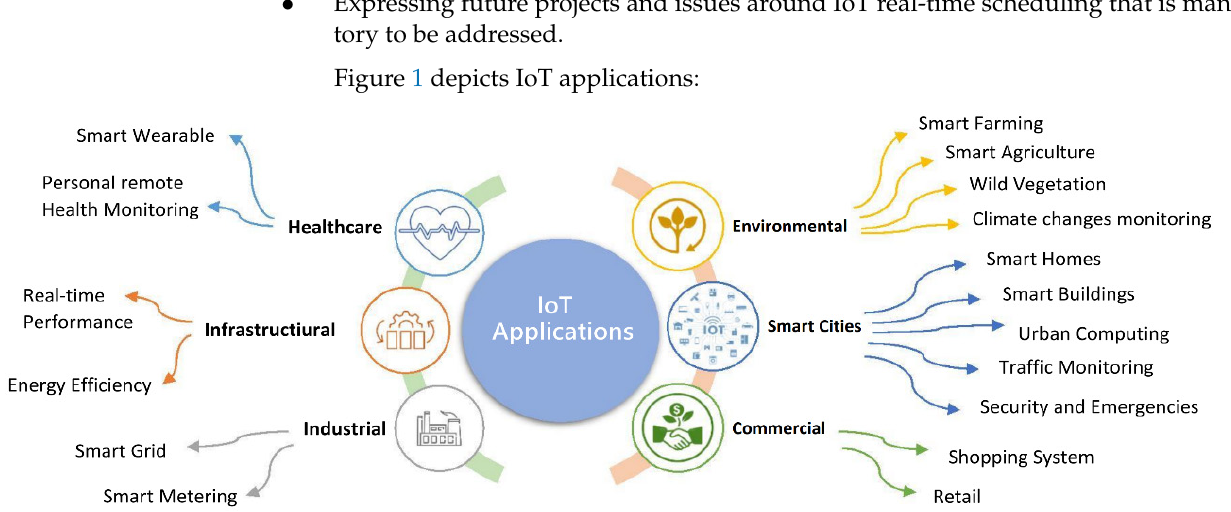
Figure 1. The IoT applications.